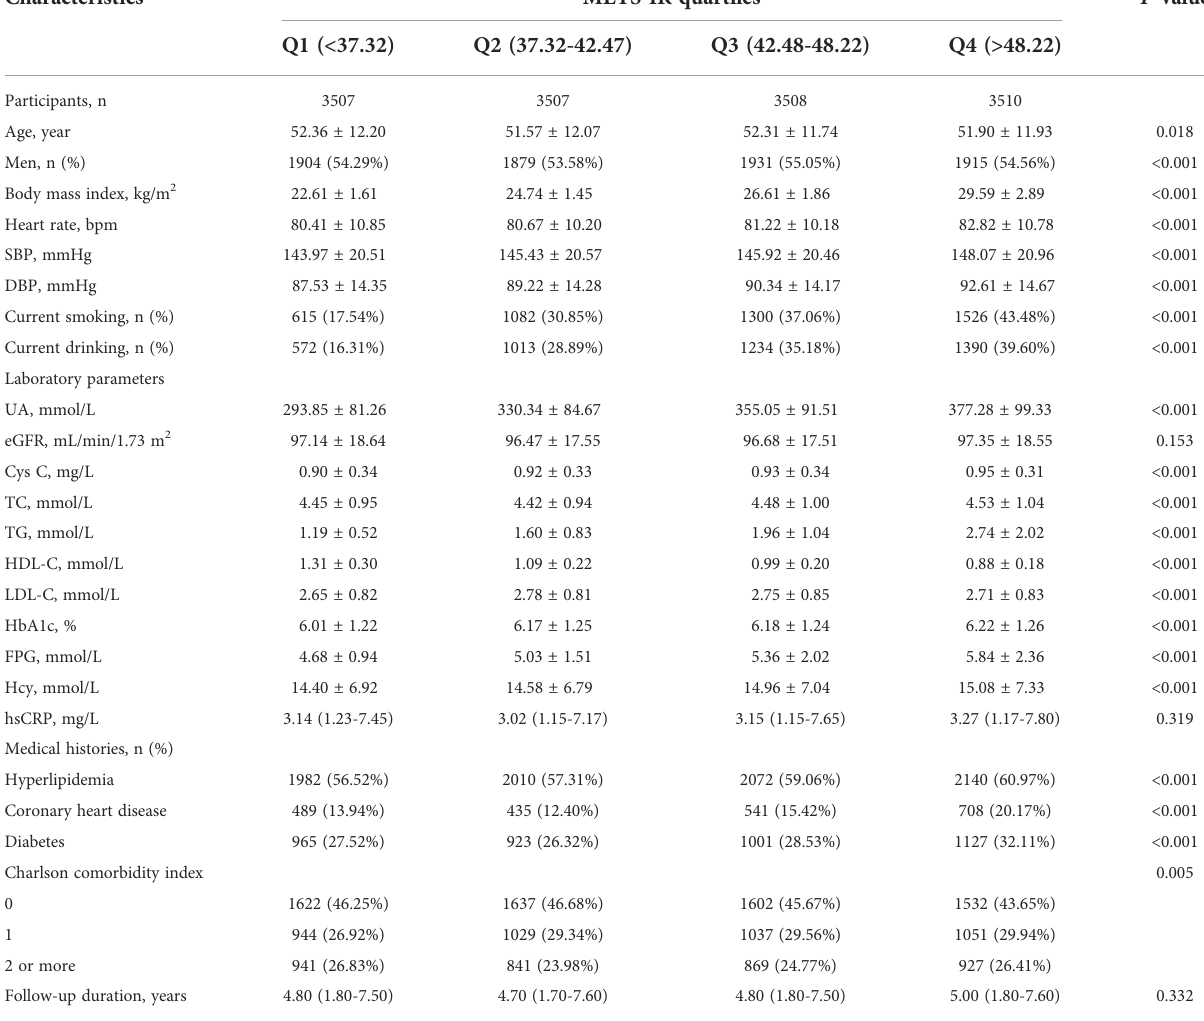
TABLE 1 Baseline characteristics of the study population according to quartiles of METS-IR.